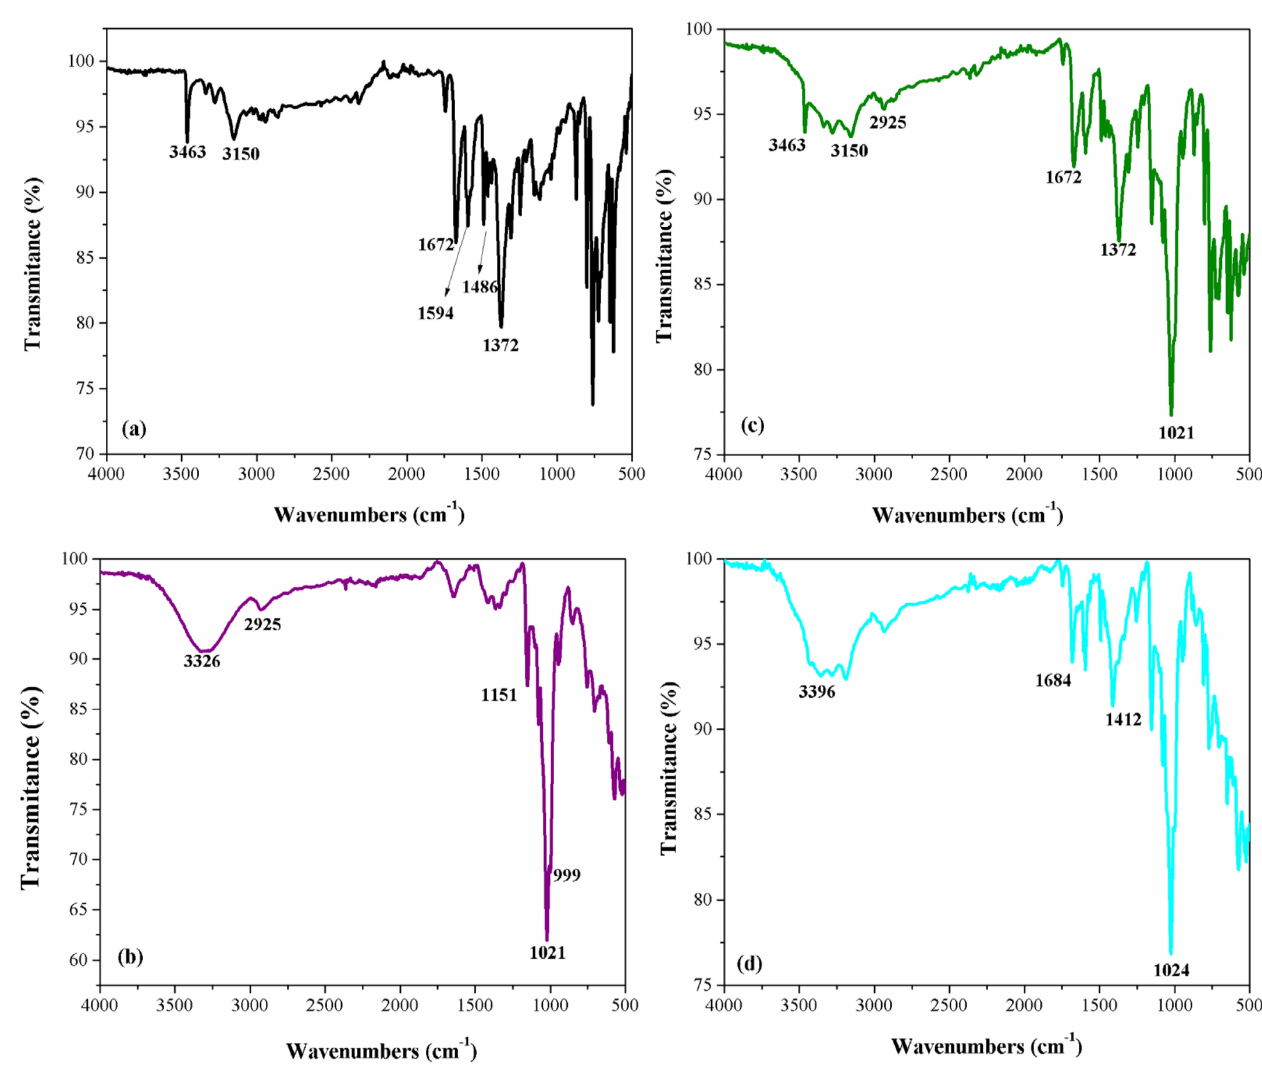
Figure 1. FTIR spectra of ( a ) CBZ, ( b ) β -CD, ( c ) CBZ- β -CD physical mixture and ( d ) CBZ- β -CD inclusion